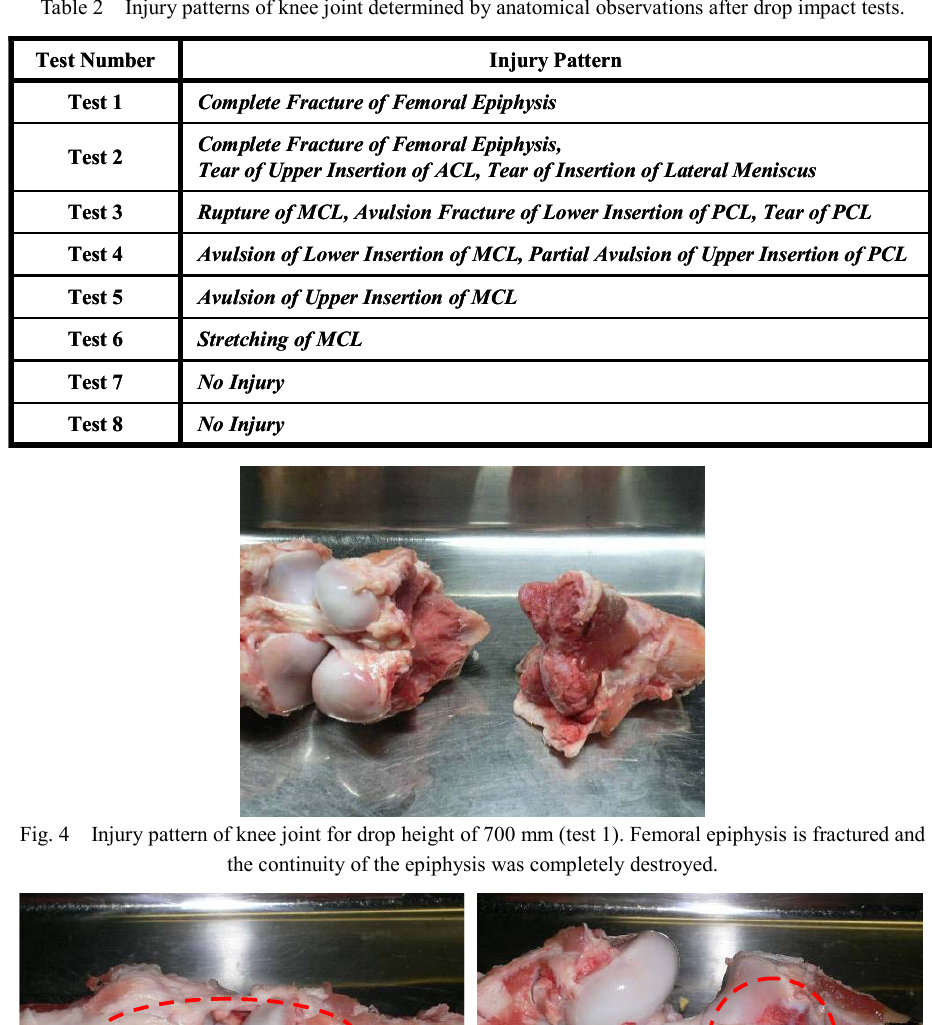
Table 2 Injury patterns of knee joint determined by anatomical observations after drop impact tests.